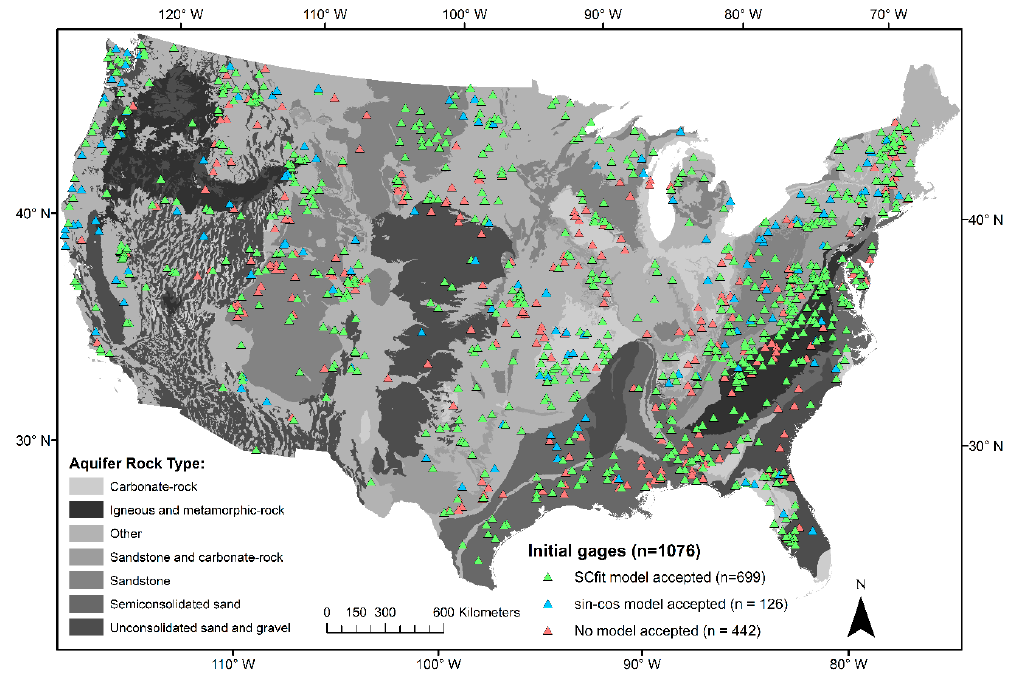
Figure 1. Select GAGES-II locations that have accepted OHS models ( SCfit and sin-cos ) or rejected OHS models (pink triangles). Accepted models span the CONUS and a variety of aquifer rock types.